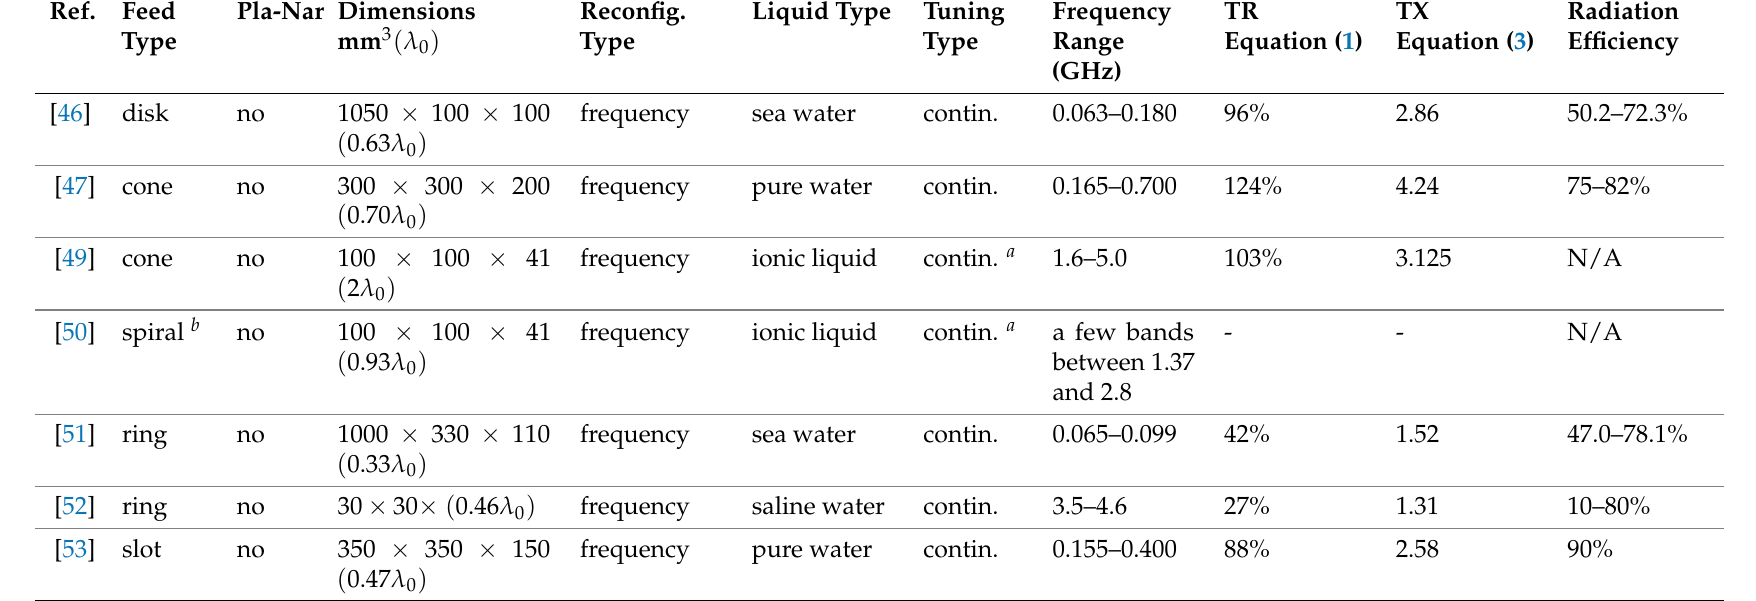
Table 2. Feeding Technique